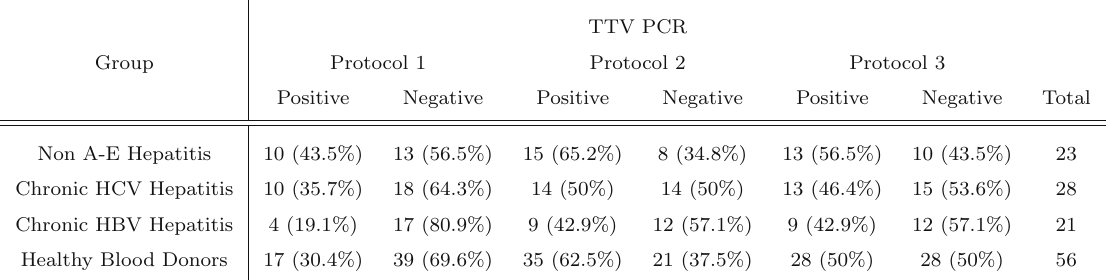
Table 3 Detection rates of TTV DNA in study groups by different PCR